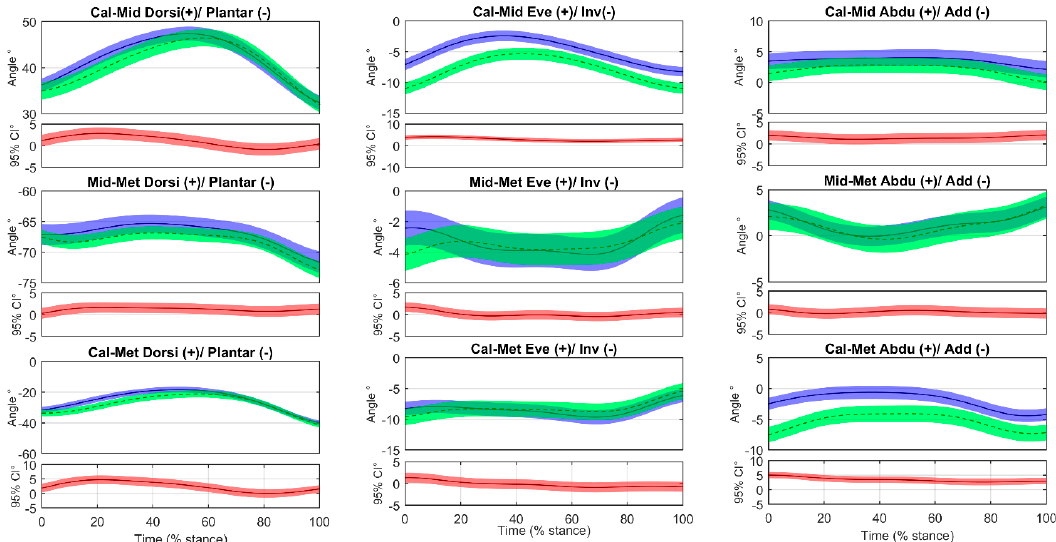
Figure 5. Midfoot with respect to the calcaneus (Cal ‐ Mid), metatarsus with respect to the midfoot (Mid ‐ Met), and metatarsus with respect to the calcaneus (Cal ‐ Met) joint angles time normalized across stance phase (0–100%) for forefoot strike (FFS) and rearfoot strike (RFS) patterns. Mean ± standard error (SE) bands are reported (shaded regions). Below of each angle plot, there is a between footstrike pattern difference plot (FFS–RFS) containing the mean ± 95% confidence interval (CI) bands (in red). Regions where those bands diverge from 0 can be considered regions of significant differences. (Legend: FFS in blue, RFS in green).